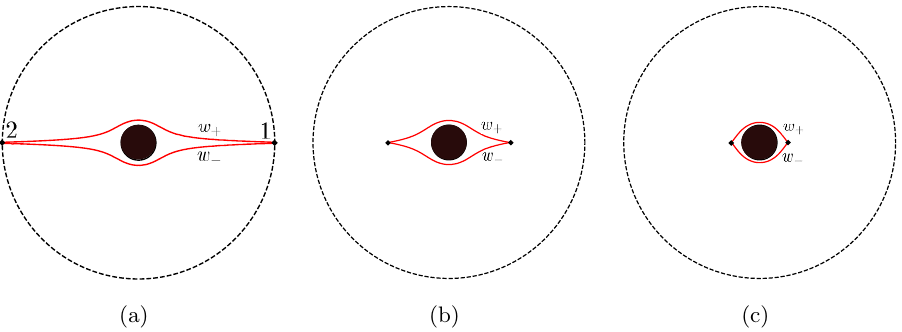
Figure 7 . Cartoon of the black hole creation in the BTZ coordinates. The space between the two red curves is the dead zone cut out by the identi(cid:12)cation. The black circle is the horizon. (a) particles start from the boundary at t = 0. (b) particles move through the bulk towards each other. (c) particles asymptotically approach the